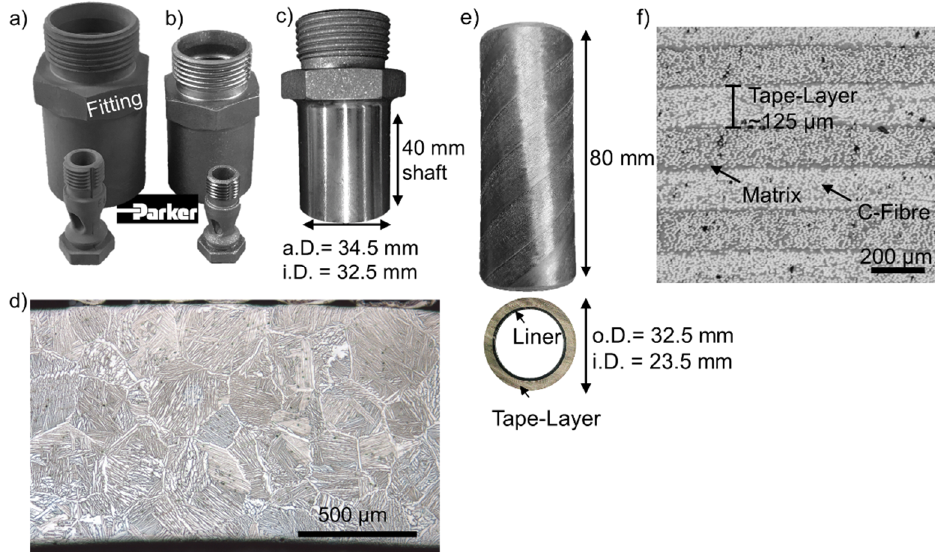
Figure 4. Dimensions and microstructure of the joining partners: ( a ) Ti6Al4V-fitting green body, ( b ) sintered Ti6Al4V-fitting, ( c ) Ti6Al4V-metal injection molded (MIM)-Fitting, turned to final dimensions, ( d ) microstructure of Ti6Al4V-fittings, ( e ) laser tape winded CF-PEEK-tube, ( f ) CF-PEEK-tube microstructure (( a , b ) with kind approval of Parker Hannifin GmbH).